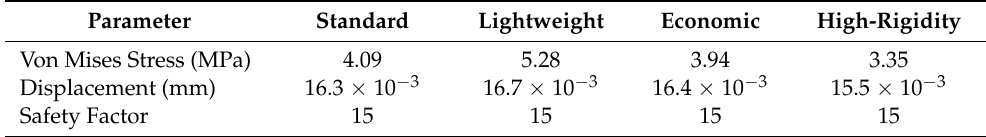
Table 5. Static Simulation Result of Overhead Crane Frame Design.